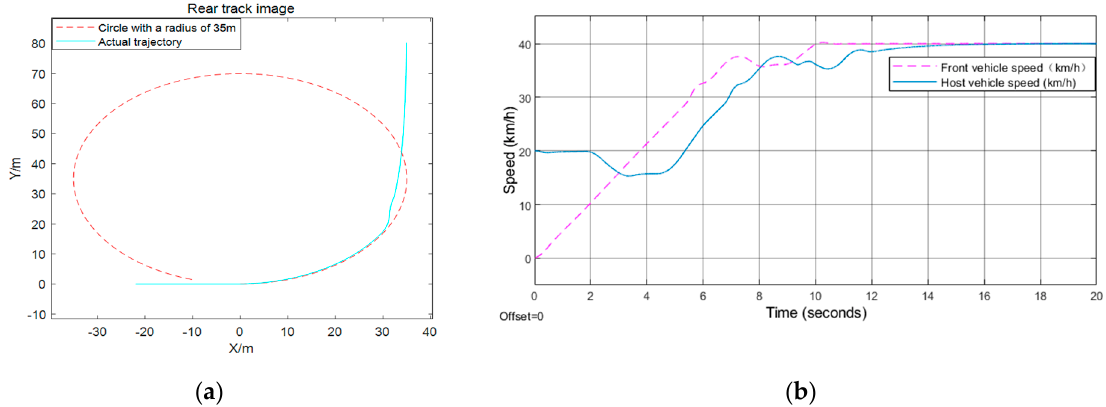
Figure 8. U ‐ turn test result: ( a ) rear track image; ( b ) front and rear vehicle speed. The front vehicle in Figure 6 starts from the stop line, the distance between the rear car and the front car is 17 m, and the speed of the rear vehicle is 20 km/h. However, in Figure 7, the initial speed of the front and rear vehicle speed is 40 km/h, the distance be ‐ tween the two is 15 m, the distance between the front vehicle and the stop line is 80 m.